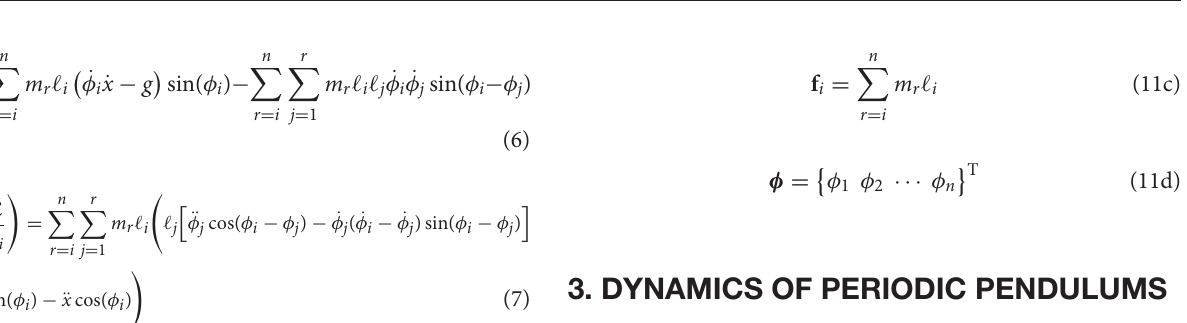
FIGURE 1 | A schematic of a gantry crane system with a periodic pendulum chain with an end payload (Left) and a corresponding simplified pendulum chain model with a tip mass (Right)